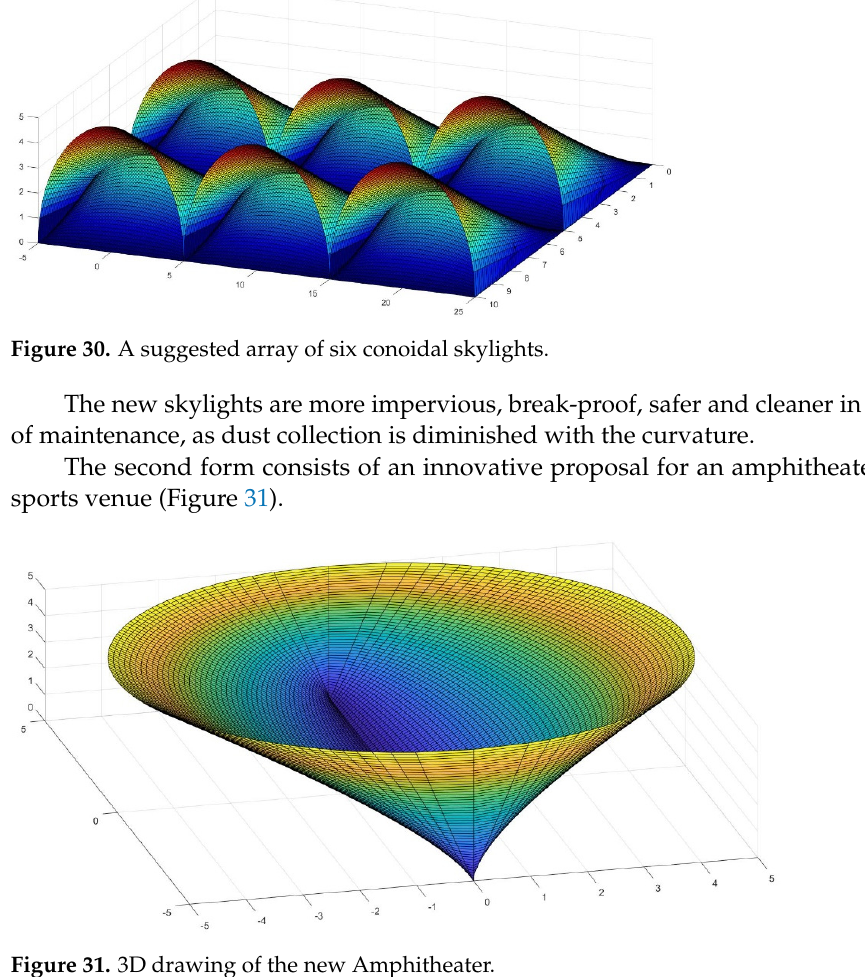
Figure 31. 3D drawing of the new Amphitheater.